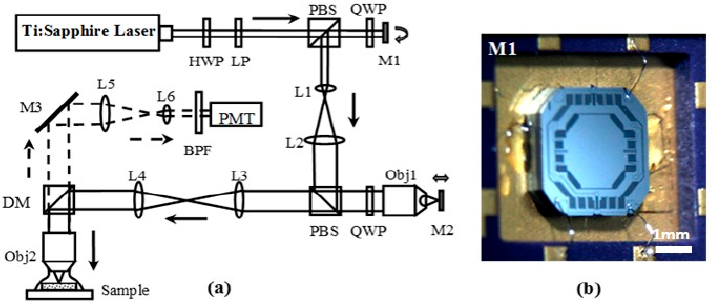
Figure 1. ( a ) Schematic for microelectromechanical systems (MEMS)-based remote scan multi-photon microscopic system. Key: HWP: half wave plate, LP: linear polarizer, L1-6: lenses, Obj1-2: objectives, M1: MEMS bi-axial torsional mirror for lateral scanning, M2: MEMS out-of-plane translational scanner, mirror, BPF: band pass filter, PMT: photomultiplier tube; ( b ) photo of MEMS bi-axial torsional